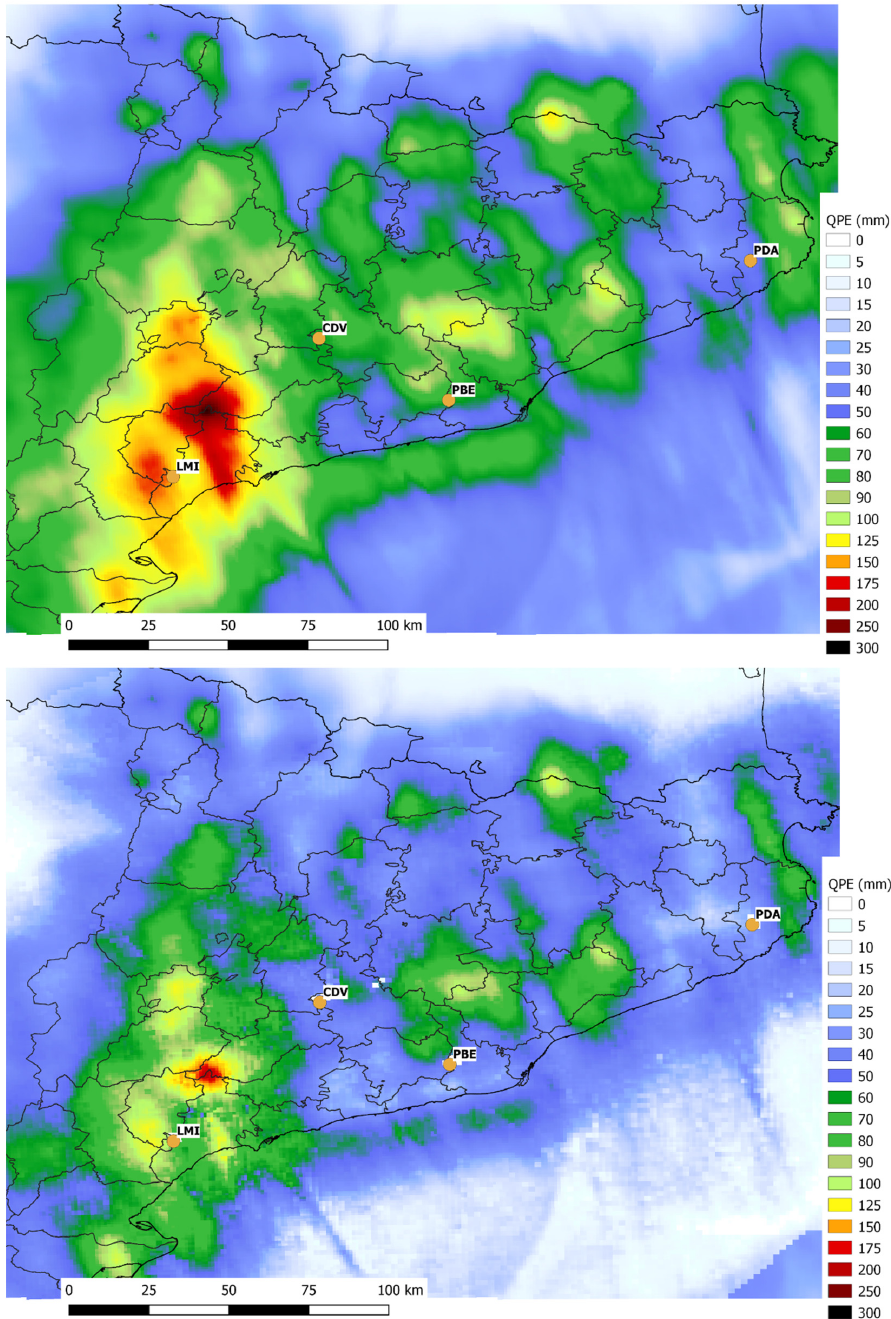
Figure 10. Top : QPE with EHIMI corrections combined with rain gauge data after the QC process for the 22 October 2019 event. Bottom : Difference in the QPE 3 re-processed field (QPE 4 ) with respect to the uncorrected one, QPE 1 (Figure 7). Using the geostatistical packages of R software [32], such as Raster [33] or MapTools [34], we reprojected and resampled all the fields to the same resolution and projection without losing any spatial information. This process allowed for a simple comparison of